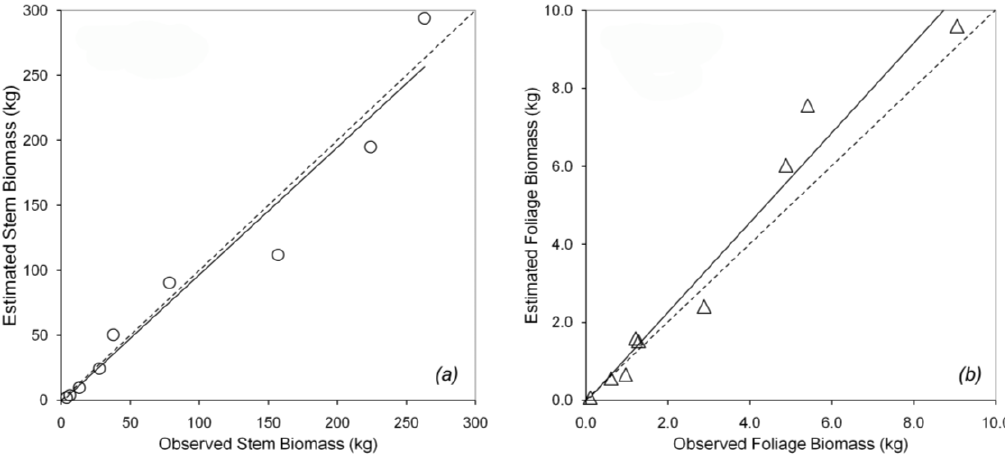
Figure 3. The estimated biomass versus the observed biomass at Hitsujigaoka for validation, the estimated values equal the observed values, (a) stem biomass (open circle); and (b) foliage biomass (open triangle). The linear regression showed y = 0.98x − 1.60 for stem biomass, and y = 1.15x − 0.04 for foliage biomass,